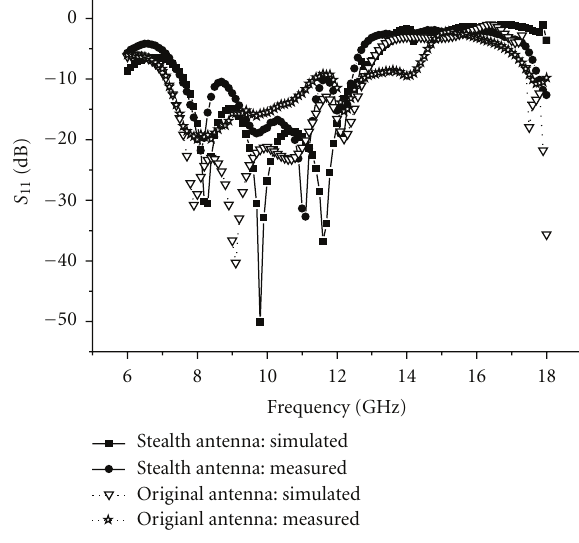
Figure 5: Return loss of the antenna.